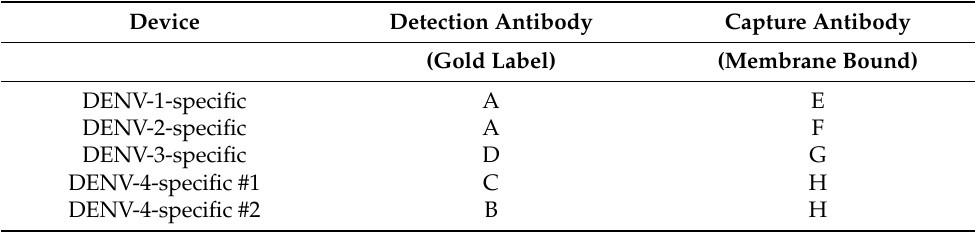
Table 1. Antibodies used in the immunochromatographic